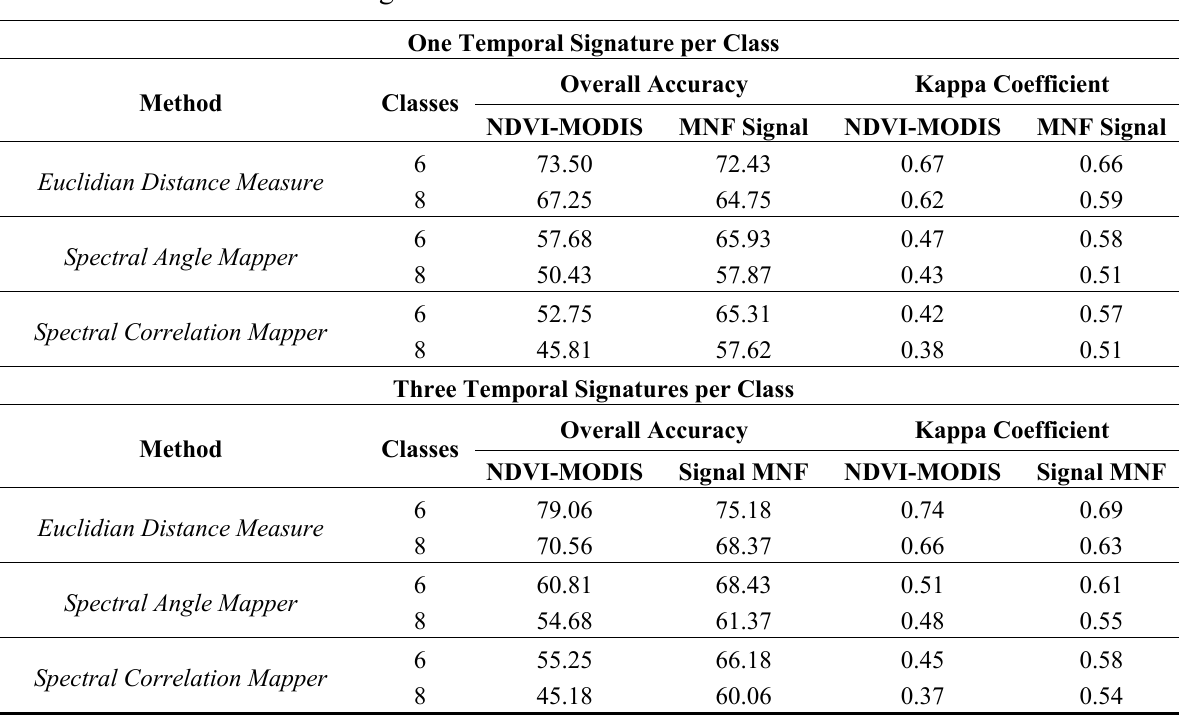
Table 4. Accuracy assessment for the classifications using two types of input data (NDVI-MODIS time series and MNF signal components), three classification measures (SAM, SCM and ED), number of curves by class (single or multiple), and the two classifications with six or eight classes.